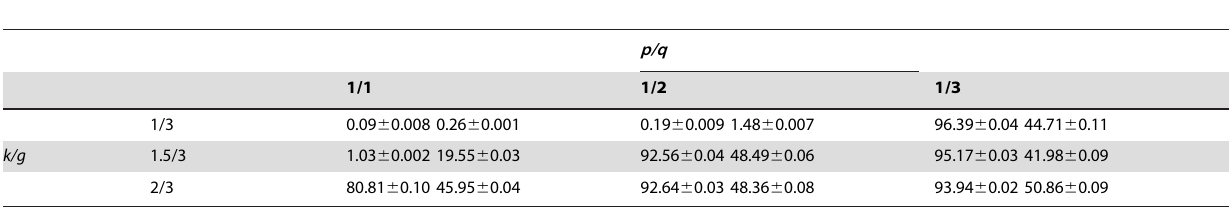
Table 2. The leveraging effect of cost to benefit ratios on cooperation and punishment.